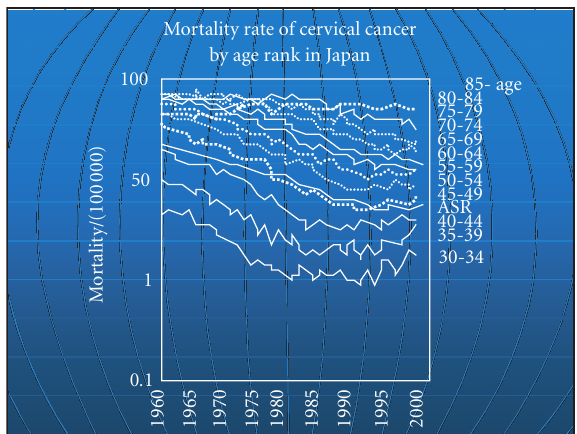
Figure 4: Mortality rate of cervical cancer by age rank in